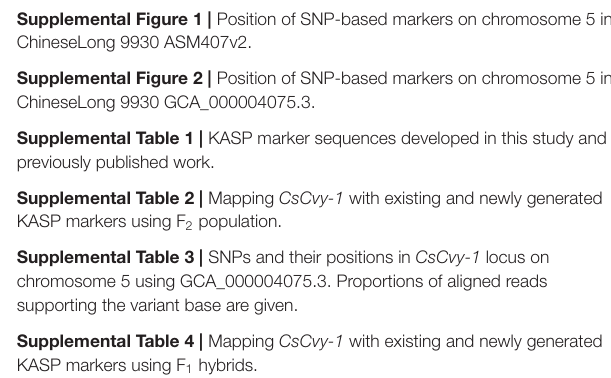
Supplemental Table 2 | Mapping CsCvy-1 with existing and newly generated KASP markers using F 2 population. Supplemental Table 3 | SNPs and their positions in CsCvy-1 locus on chromosome 5 using GCA_000004075.3. Proportions of aligned reads supporting the variant base are given. Supplemental Table 4 | Mapping CsCvy-1 with existing and newly generated KASP markers using F 1